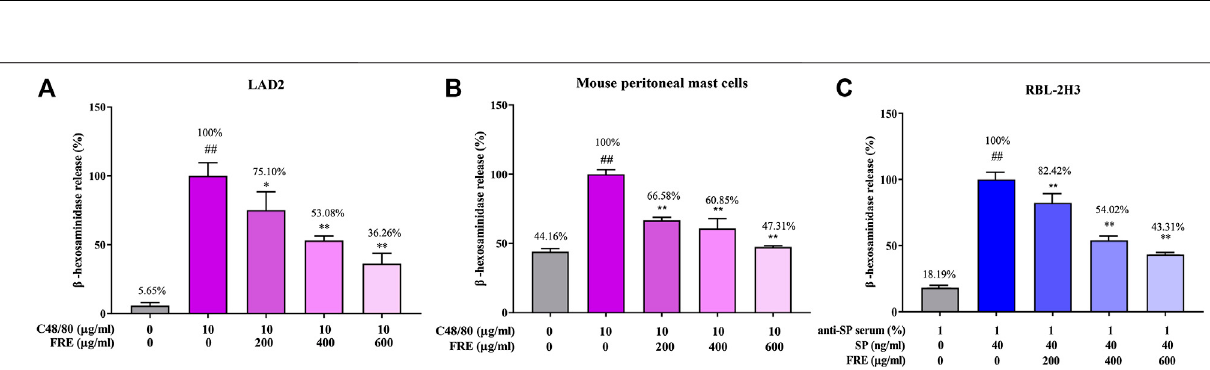
FIGURE 2 | FRE did not impair cell viability of MPMCs (A) and RBL-2H3 cells (B) ( n (cid:2) 3). The cells were pretreated with FRE for 2 h and the extracellular LDH was determined. # p < 0.05, ## p < 0.01 vs. control.